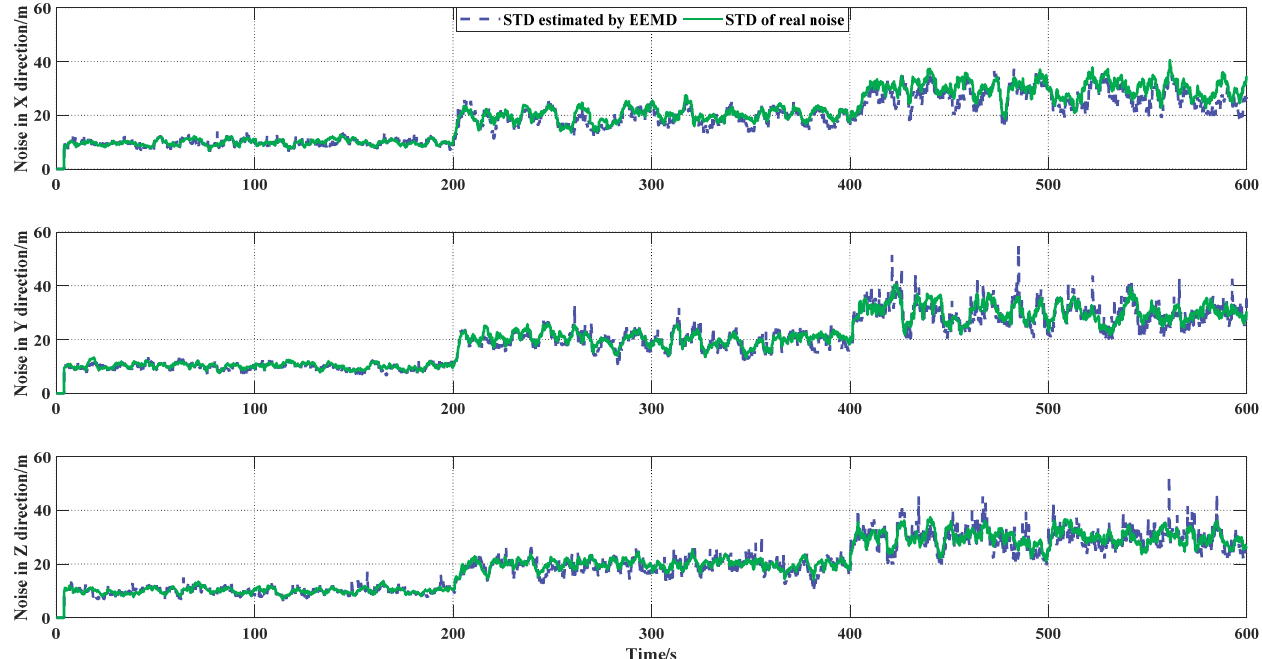
Figure 4. Proof of algorithm following effect. The green curve represents standard deviation (STD) of real noise, the blue curve represents STD estimated by EEMD.